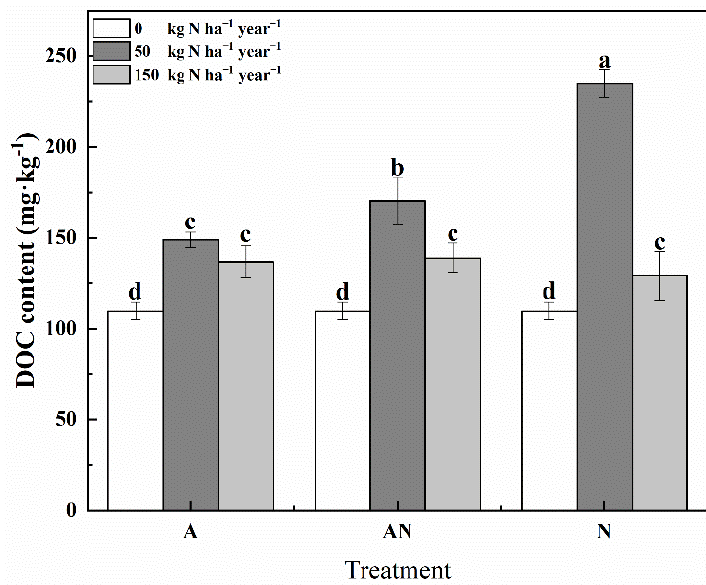
Figure 2. Content of dissolved organic carbon under different N addition. Vertical bars represent ± SE ( n = 3). A, (NH 4 ) 2 SO 4 ; AN, NH 4 NO 3 ; N, NaNO 3 . Means with different lowercase letters are significantly different at p < 0.05.